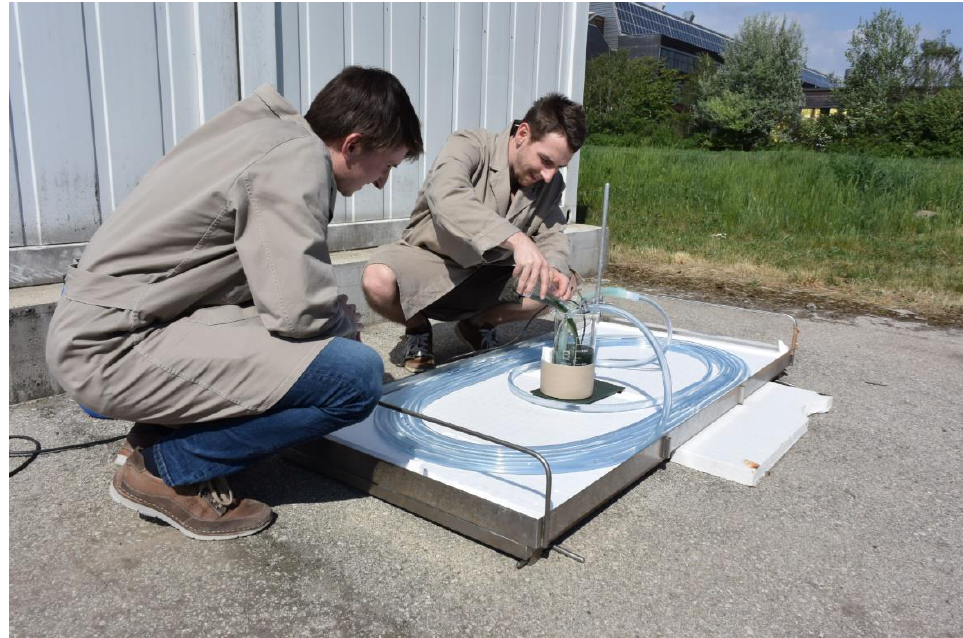
Figure A2. Inoculation of the 5-L tubular photobioreactor in Tulln with Synechocystis sp. IFA-3 for outdoors operation.